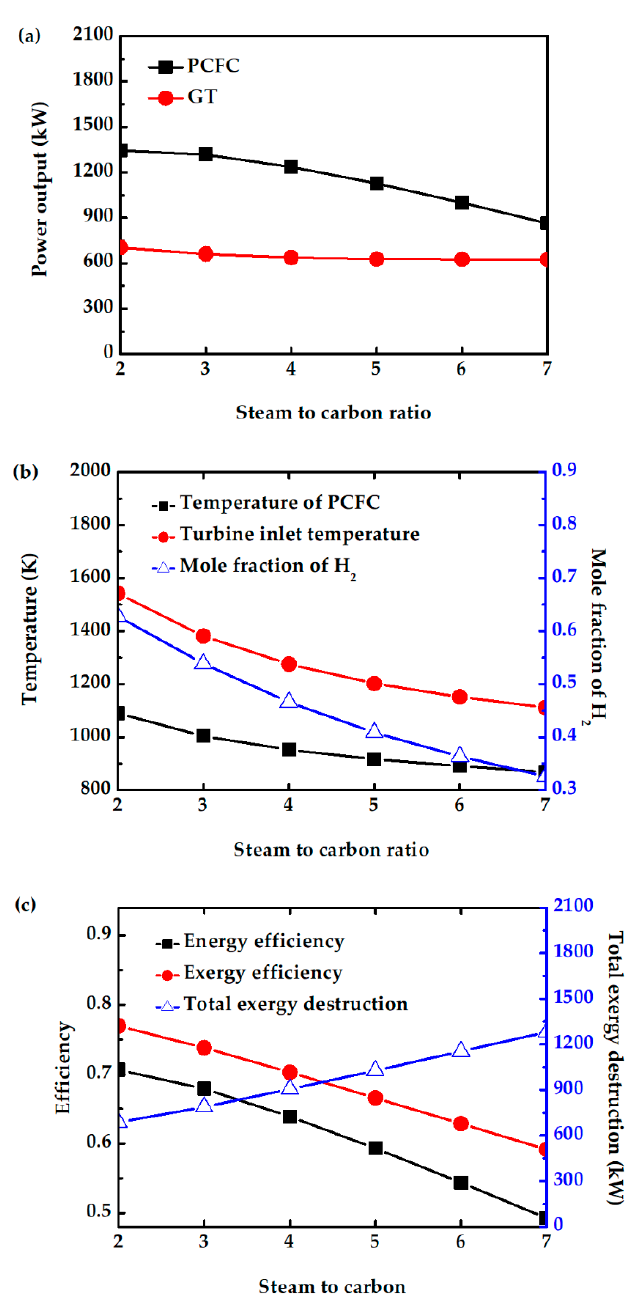
Figure 9. Effect of S/C on ( a ) power output of PCFC and GT, ( b ) PCFC operating temperature, turbine inlet temperature, and mole fraction of H 2 , and ( c ) exergy efficiency, energy efficiency and total exergy destruction.